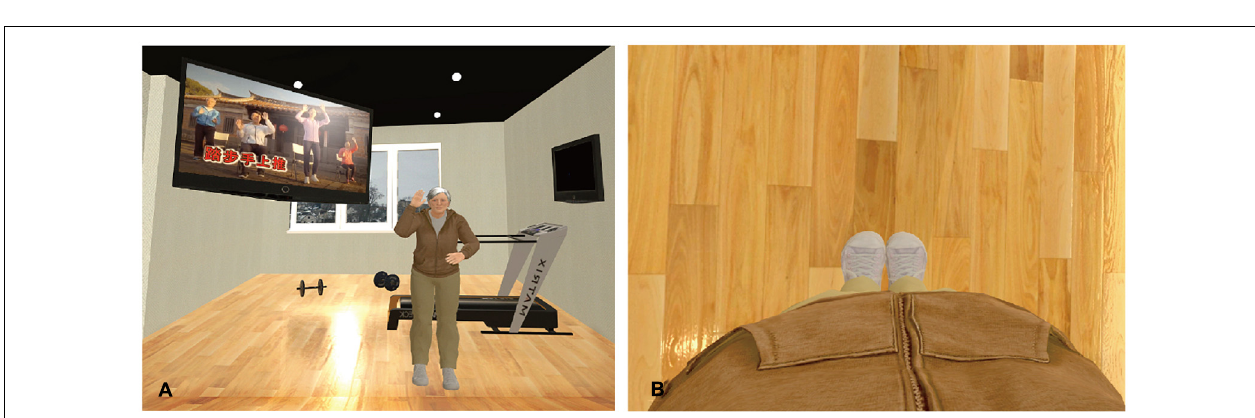
FIGURE 3 | The environment of the virtual gym. (A) Overview of the virtual environment for the elderly self-avatar in the exercise phase. (B) Participants could see their virtual body from a first-person perspective.